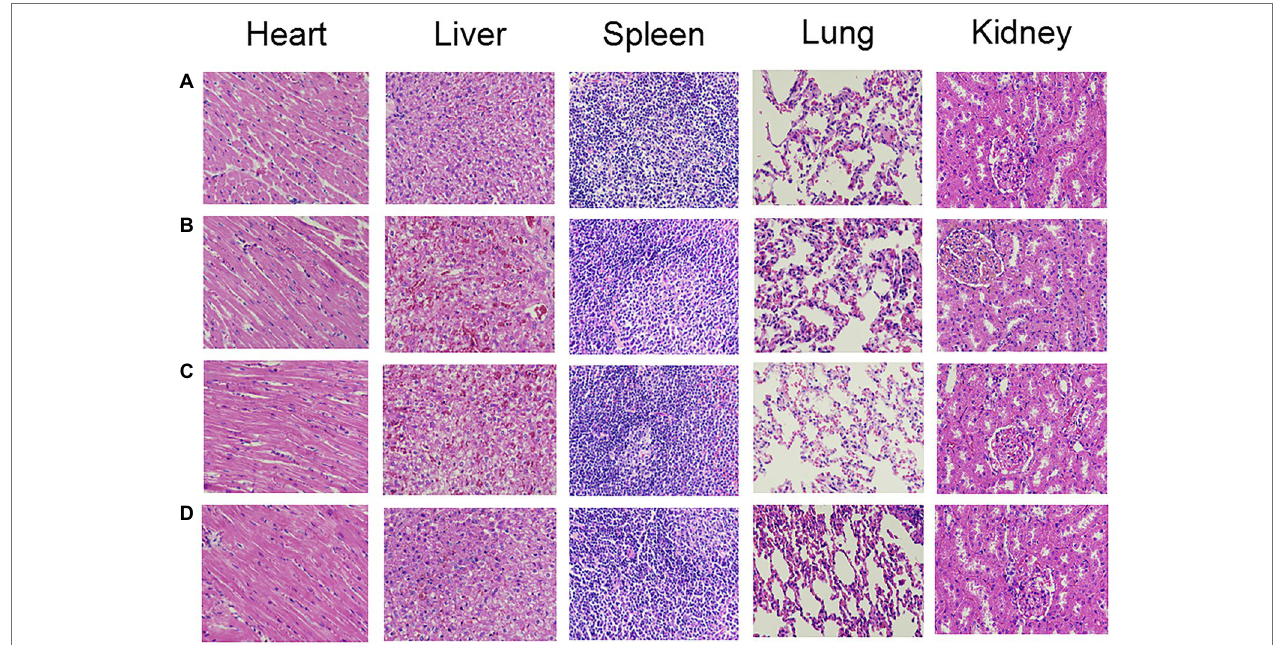
FIGURE 7 | The HE staining results of organs in each group. (A-D) represent the control group, GM group, PACT group, and PACT + GM group, respectively.